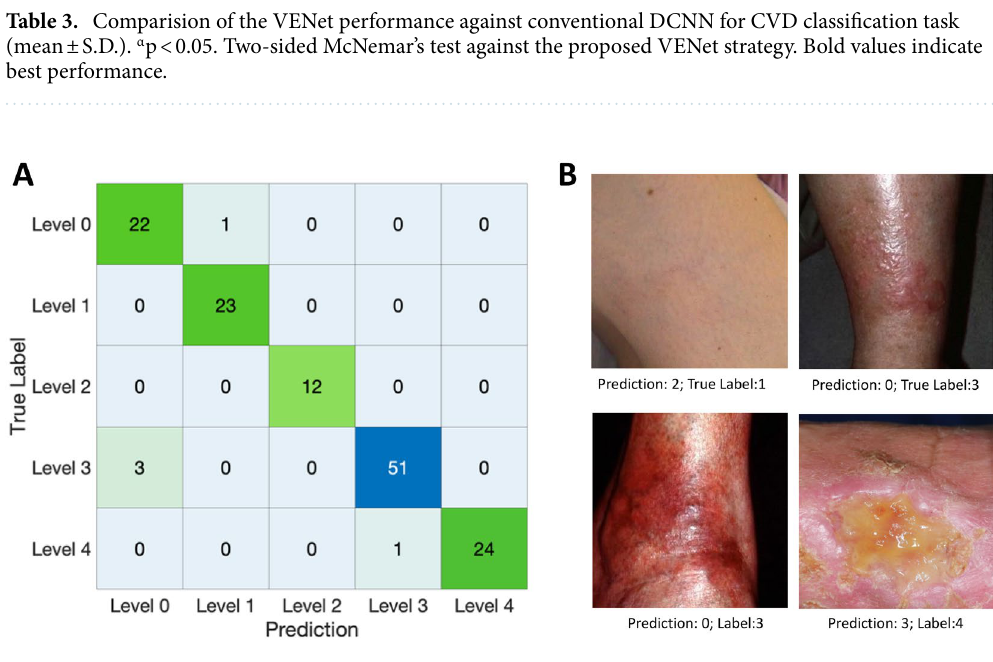
Figure 4. Confusion matrix of the proposed VENet for the classification of CVD images from the validation dataset. ( A ) Confusion matrix in each row represent the true label, while the column represents the VENet predicted classification. ( B ) Example pf wrong classified images by